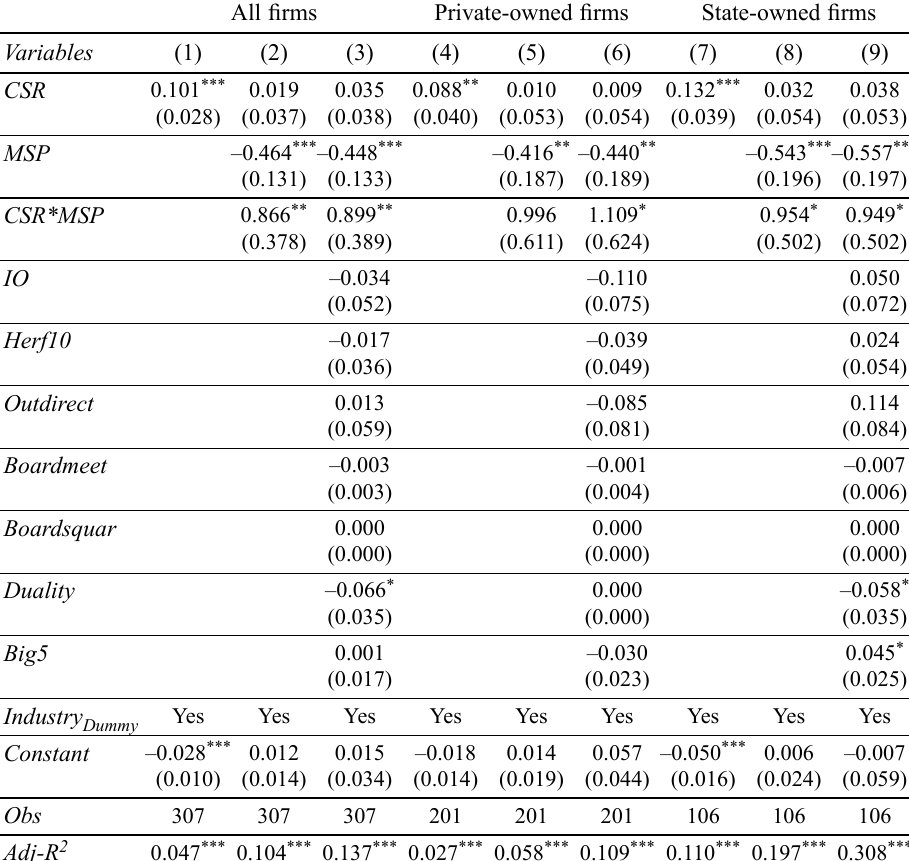
Table 5. CSR , Minority shareholder participation, and firm market